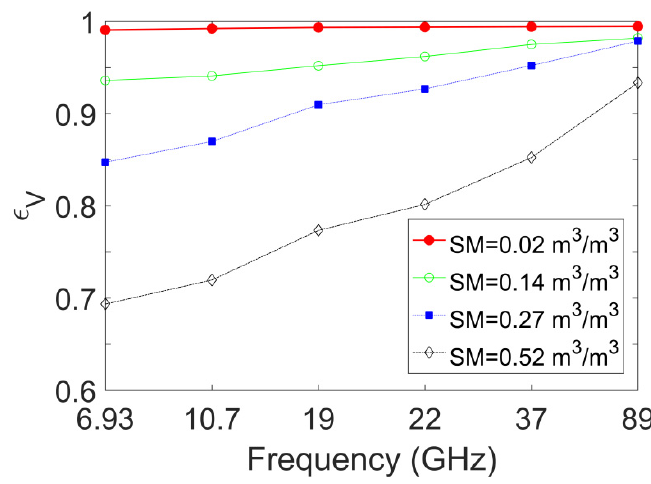
Figure 2. Vertically polarized emissivities versus di ff erent frequencies for four surface soil moistures (SM).